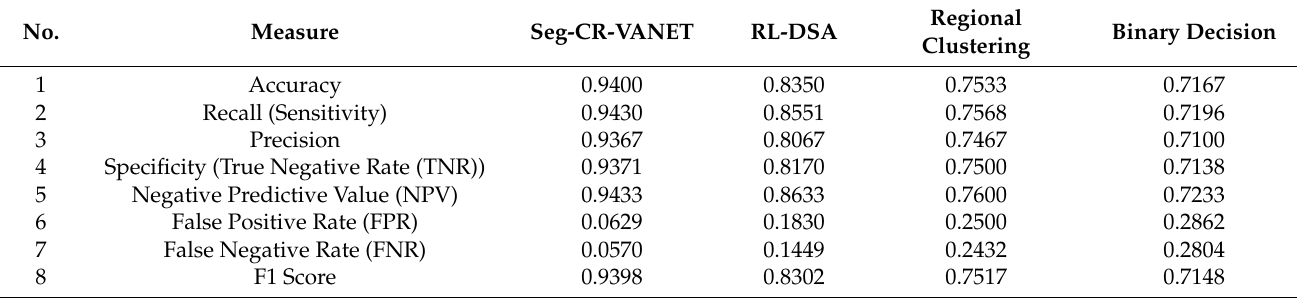
Table 9. Performance